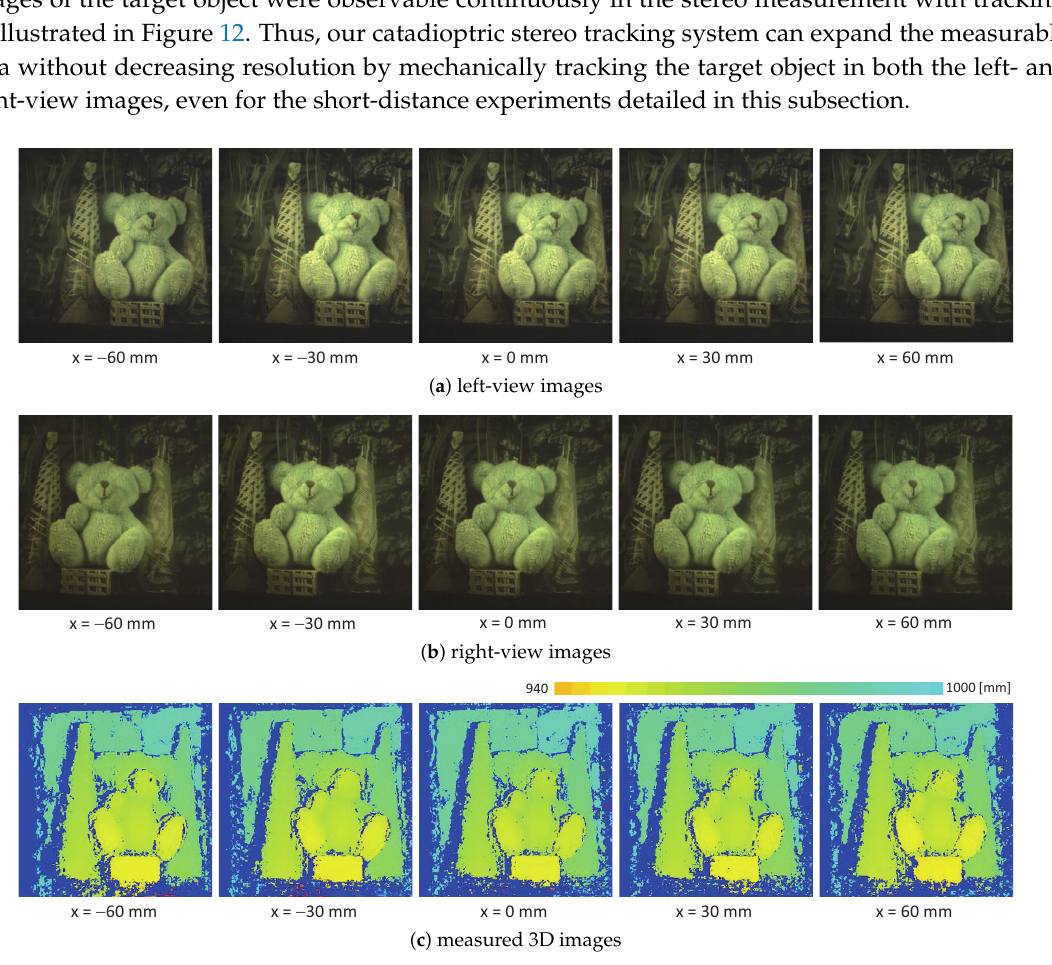
Figure 12. Measured 3D images for stationary 3D scenes at different x -coordinates when the target object was mechanically tracked in both the left- and right-view images: ( a ) left-view images; ( b ) right-view images; ( c ) measured 3D